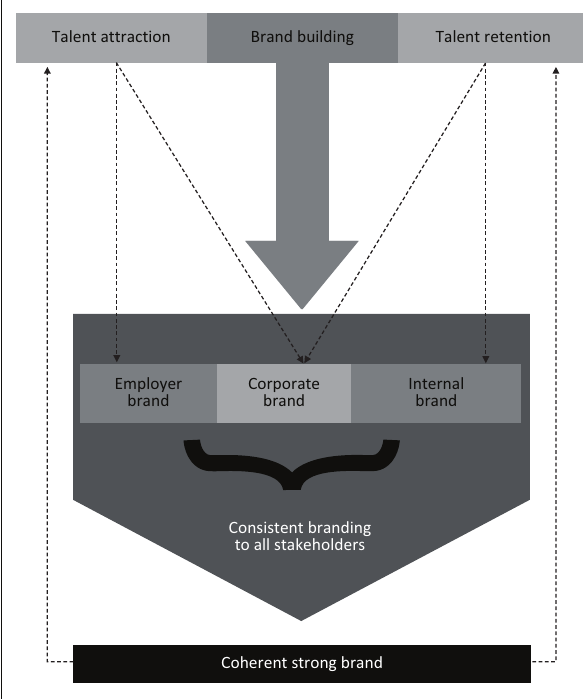
FIGURE 1: Theoretical framework – Key constructs and relationships between